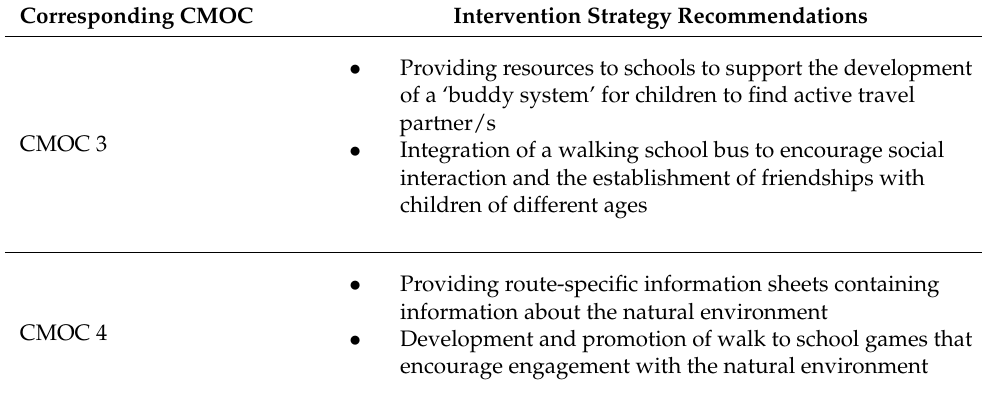
Table 4. Recommended context-specific intervention strategies by